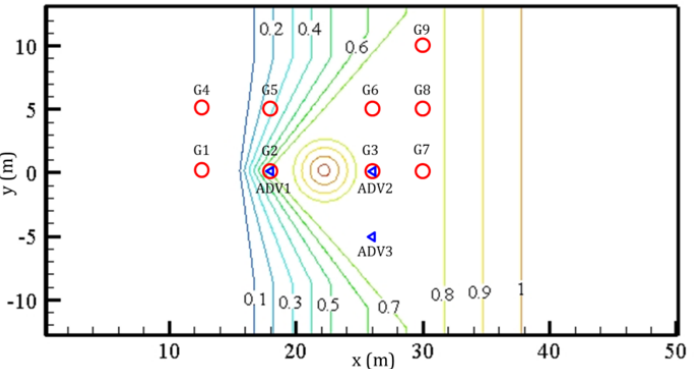
Figure 14. Contours and locations of measuring points (“circle” symbols are the gauges for water surface fluctuation measurement, and “triangle” symbols are the acoustic Doppler Velocimeters (ADVs) for velocity